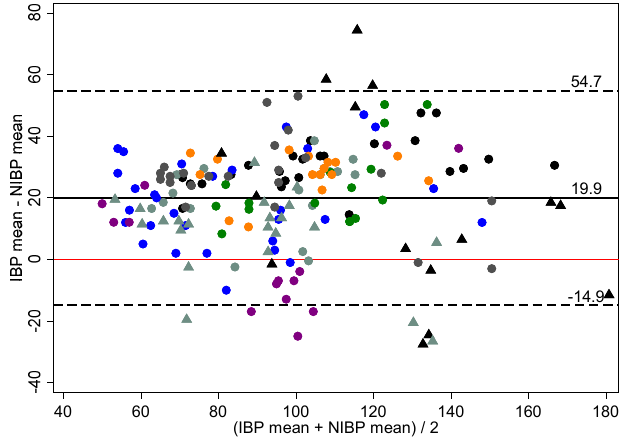
Figure 4. Bland–Altman plot of agreement for 179 paired mean arterial blood pressure measurements (mm Hg) made non-invasively compared to those made invasively using the Bionet BM7Vet in 9 healthy, standing horses. The non-invasive arterial blood pressure cuff was placed at the proximal tail base. Repeated observations from the same horse are plotted using the same colour-shape combination. The solid black line indicates mean bias, and the dashed lines indicate lower and upper limits of agreement. The solid red line represents zero bias. IBP invasive blood pressure, NIBP non-invasive blood pressure. Bias defines accuracy.